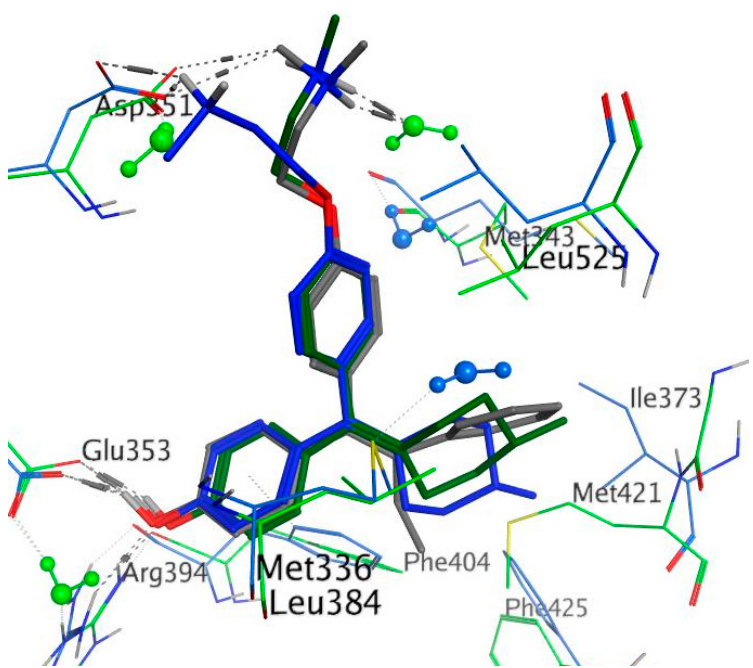
Figure 3. Ranked poses of 11e in ER α and ER β overlaid on 4-OHT X-ray structure. Carbon atoms of 11e are illustrated in dark green in ER α , dark blue in ER β and grey in 4-OHT (oxygen atoms are red; nitrogen in dark blue; sulphur in yellow). ER α and associated water molecules are in light green, ER β and associated water molecules are in light blue. Amino acid numbering is for ER α except when different in ER β where both labels are used. PDB structures 3ERT [69] and 1NDE [70] were used for molecular docking.